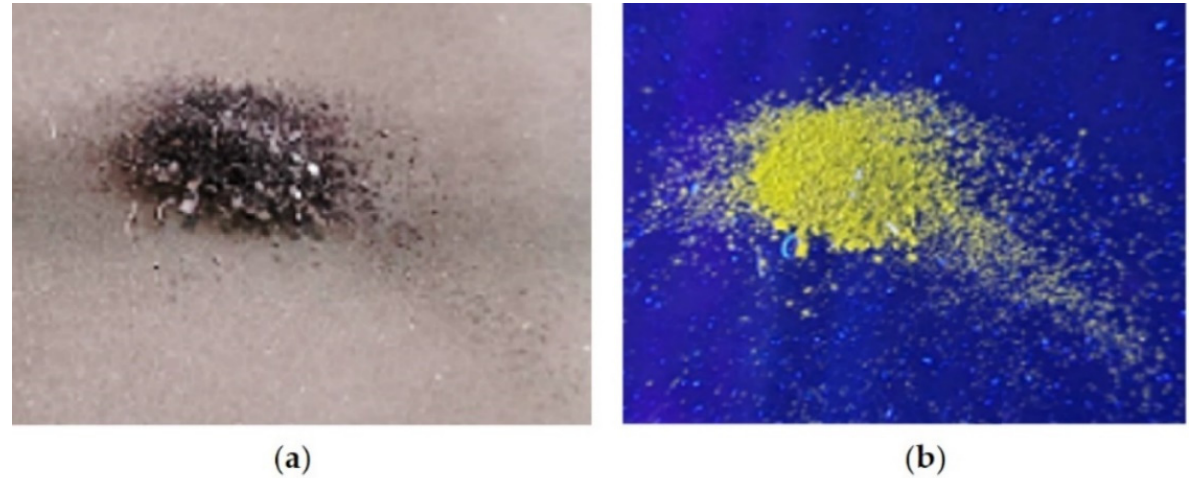
Figure 7. The effect of UV light (365 nm) on a powdery sample of H 3 L-CuO NPs; ( a ) under natural light, ( b ) under UV light (365 nm).